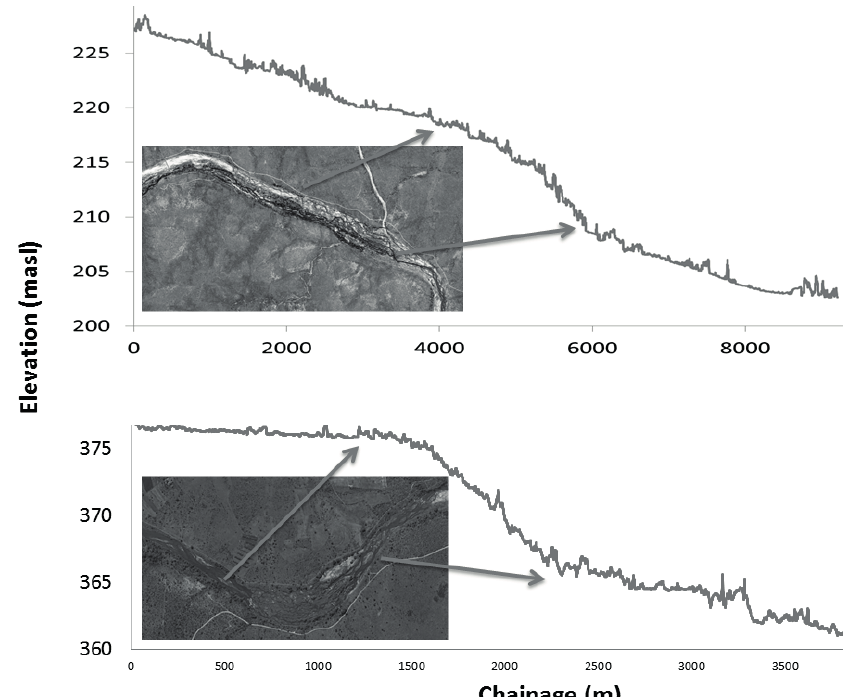
Fig. 3 Example LIDAR long profiles from bedrock or mixed anastomosed reaches of the Sabie River. Limits of the anastomosed reaches are indicated by arrows with more alluviated reaches